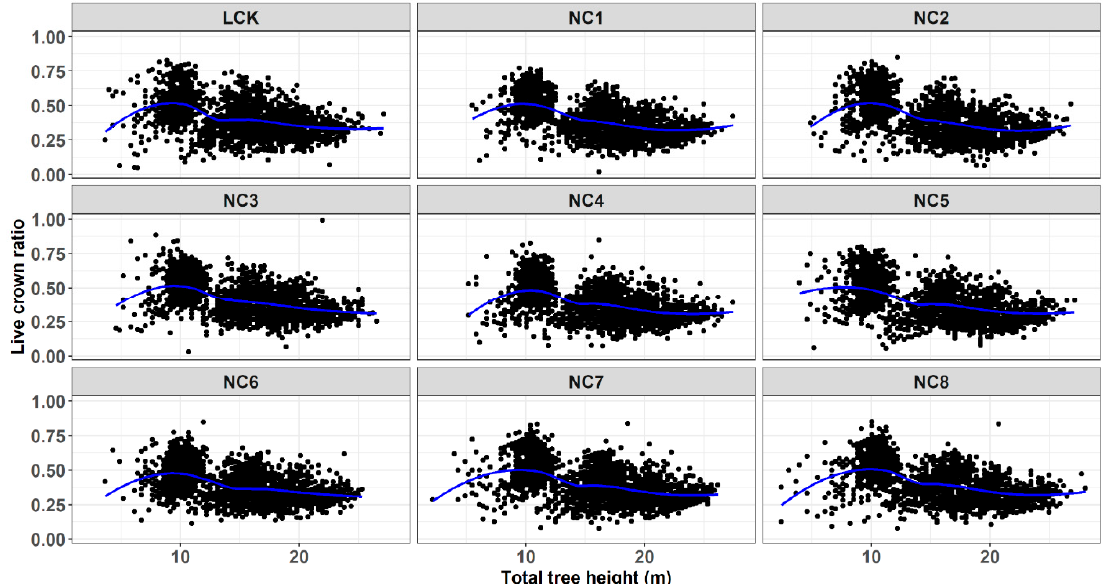
Figure 2. Relationship between live crown ratio (LCR) and total tree height for different families of loblolly pine. LCR slightly increased with increasing height and then declined and stabilized. This trend was consistent when plotted by family and spacing.